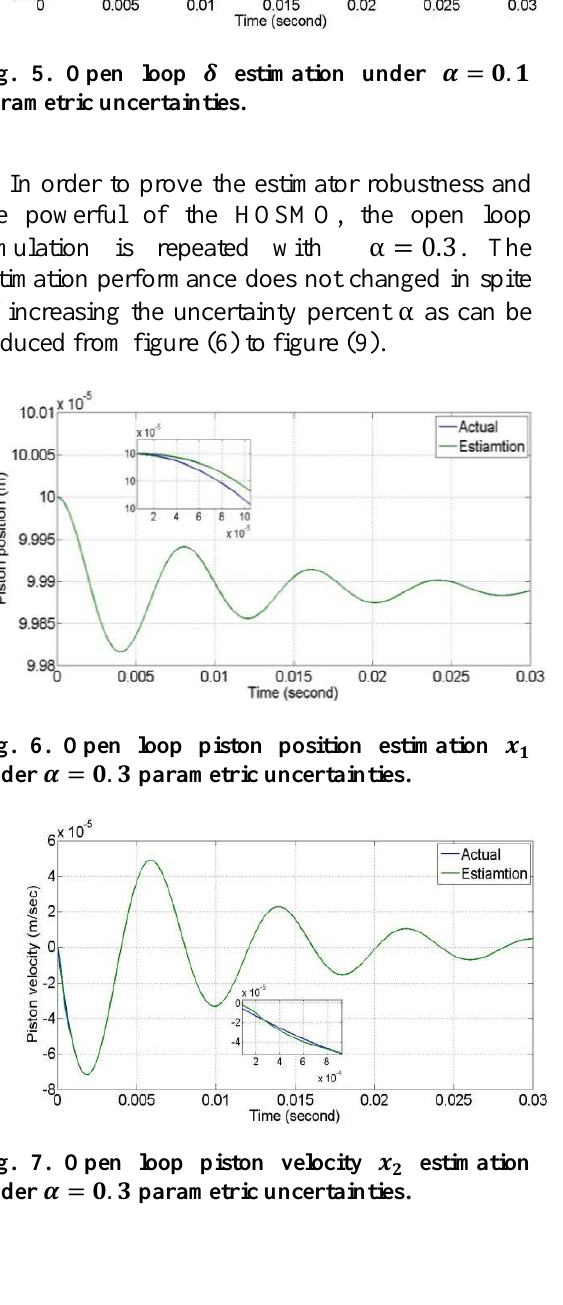
Fig. 7. Open loop piston velocity under parametric uncertainties. (cid:159) = (cid:160). £